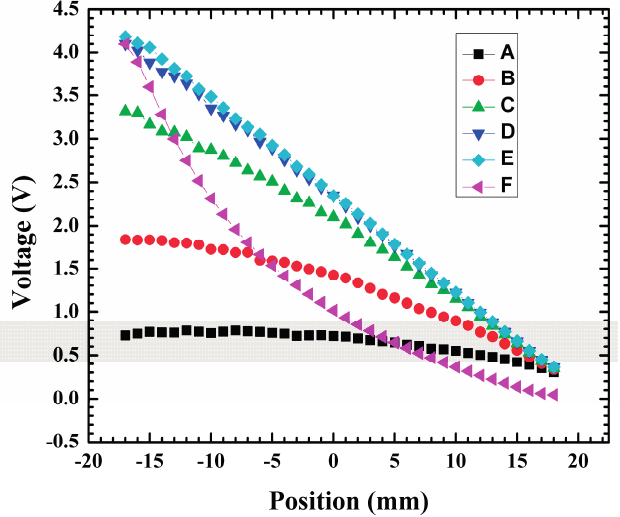
Figure 6. Output voltage vs. position measurements for various light positions (A = − 0.4 mm, B = − 0.2 mm, C = 0 mm, D = 0.2 mm, E = 0.4 mm, F = 0.4 mm). At positions A–E the 0–5 V bias was applied to the bias line and the floating potential measured on the floating line. For position F, the 0–5 V bias was applied on the floating line and the floating potential measured on the biased